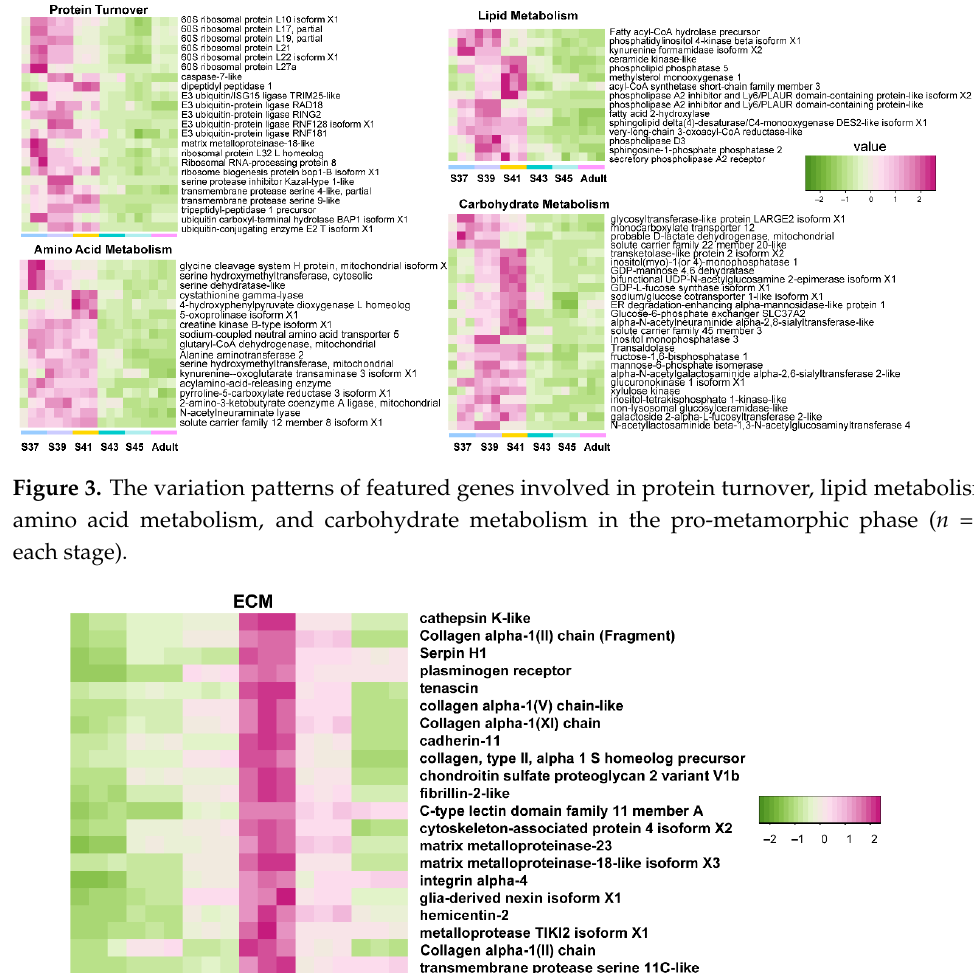
Figure 5. The variation patterns of featured genes involved in substrate metabolism, energy metabolism, and muscle contraction in the post-metamorphic phase ( n = 3 each stage).